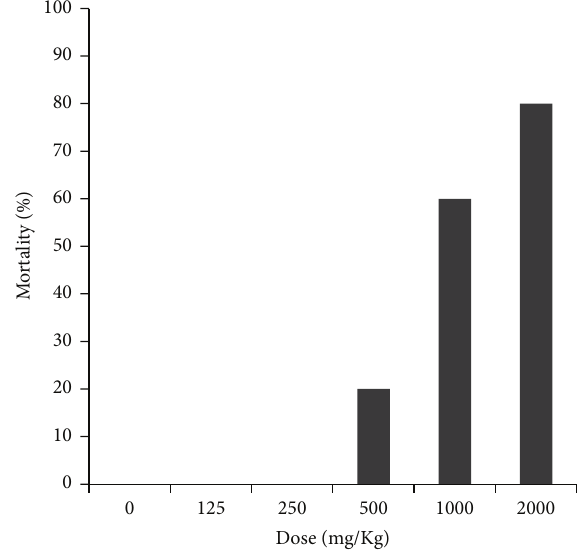
Figure 1: Percentage of mortality for determining the acute toxicity of the P. americana seed